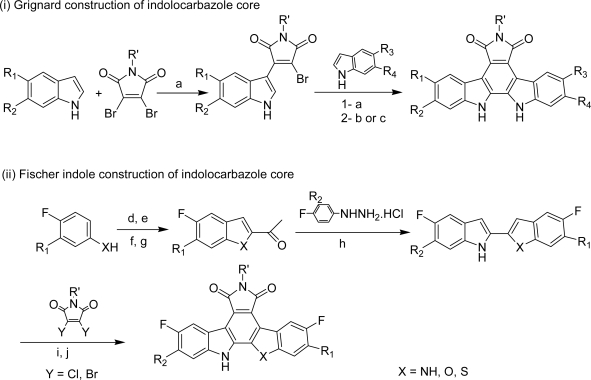
(a) 3M EtMgBr in THF, PhH, 80 °C. (b) DDQ, APTS, PhH, 80 °C. (c) hν, cat. I2, air, PhH, 80 °C. (d) NaOEt, EtOH, ClCH2CH(OEt)2, rt. (e) PPA, PhCl, 100 °C. (f) nBuLi, CH3CHO, THF/Et2O (1/1), −78 °C to 0 °C. (g) PCC, CH2Cl2, celite, rt. (h) EtOH, NaOAc, 75 °C. (i) 3M EtMgBr in THF, THF. (j) hν, EtOH, dioxane, 100 °C